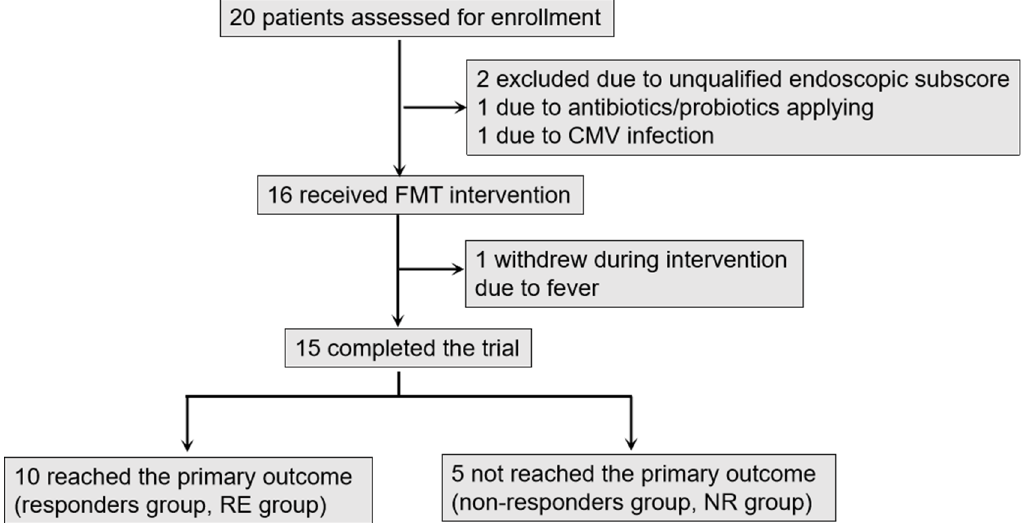
Figure 1. The flow of patients in the trial. 10 patients reached the primary outcome. The participants were then classified into RE group ( n = 10) and NR group ( n = 5) according to the primary outcome results.